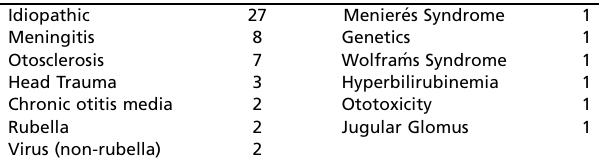
Table 1 - Deafness aetiologies recorded in the sample before the CI procedure.